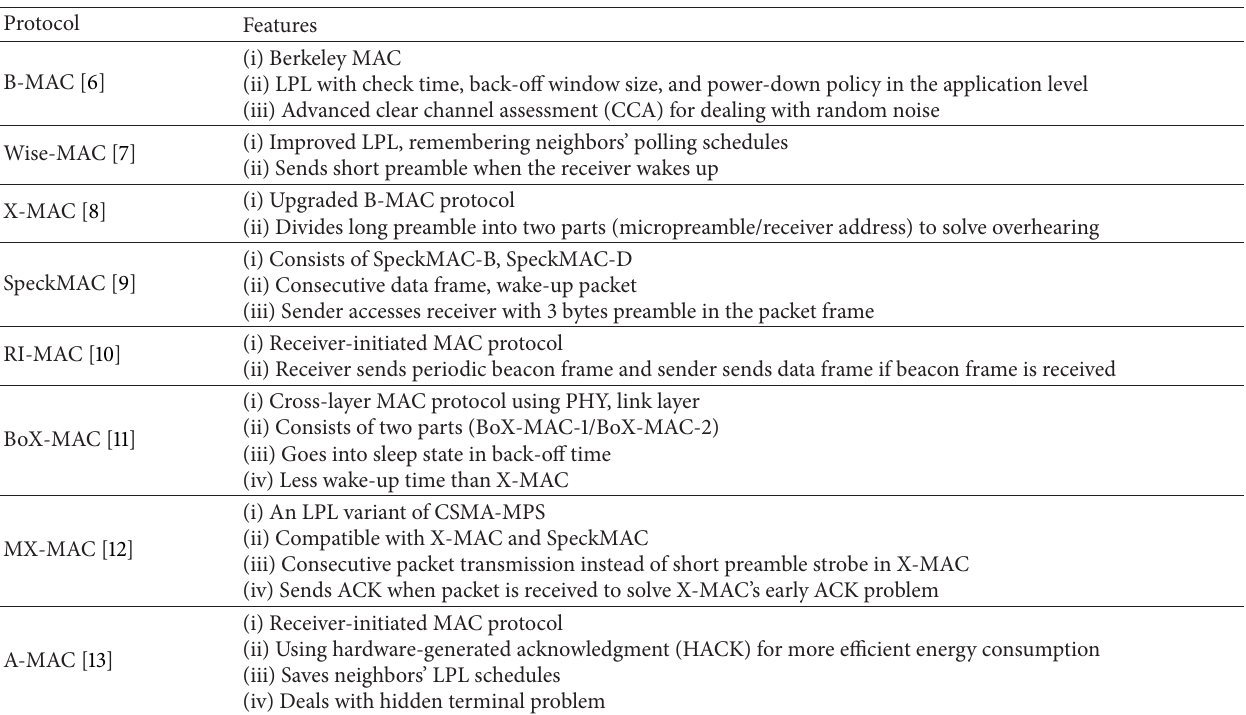
Table 1: LPL MAC